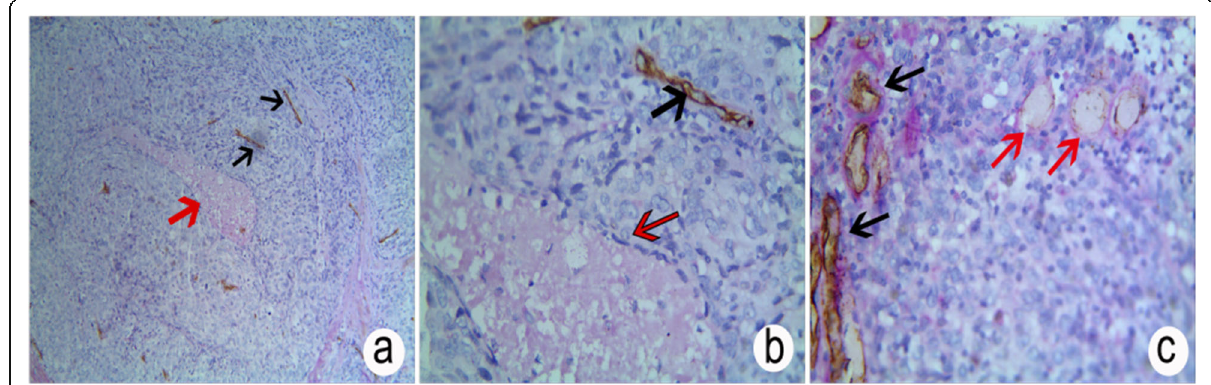
Fig. 1 Positive staining of VM and micro-vessels in ESCC through CD34 + PAS double staining. a Positive staining of VM and micro-vessels in ESCC (×100); b and c : Positive staining of VM and micro-vessels in ESCC (×400). Red arrows represent VM; black arrows: micro-vessels